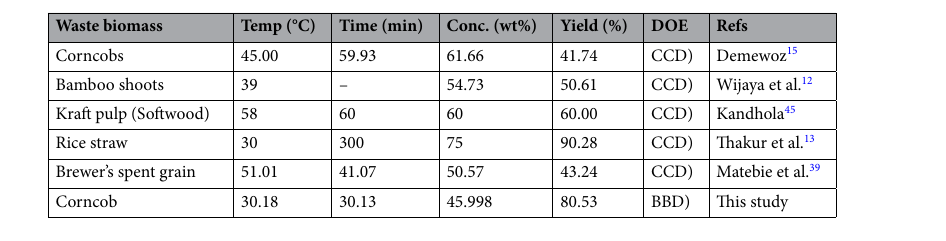
Table 6. Comparison of results with